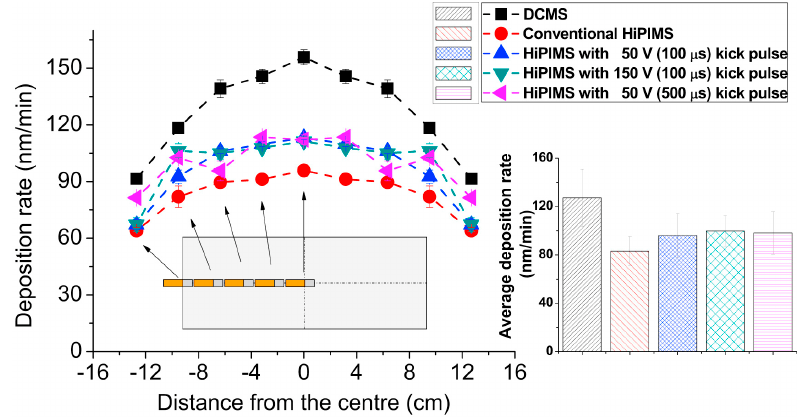
Figure 11. Results relatively to Cu films deposition rate. Average deposition rates for all the samples at different positions in the reactor. Reproduced from [101] with permission. Copyright 2018 Elsevier.